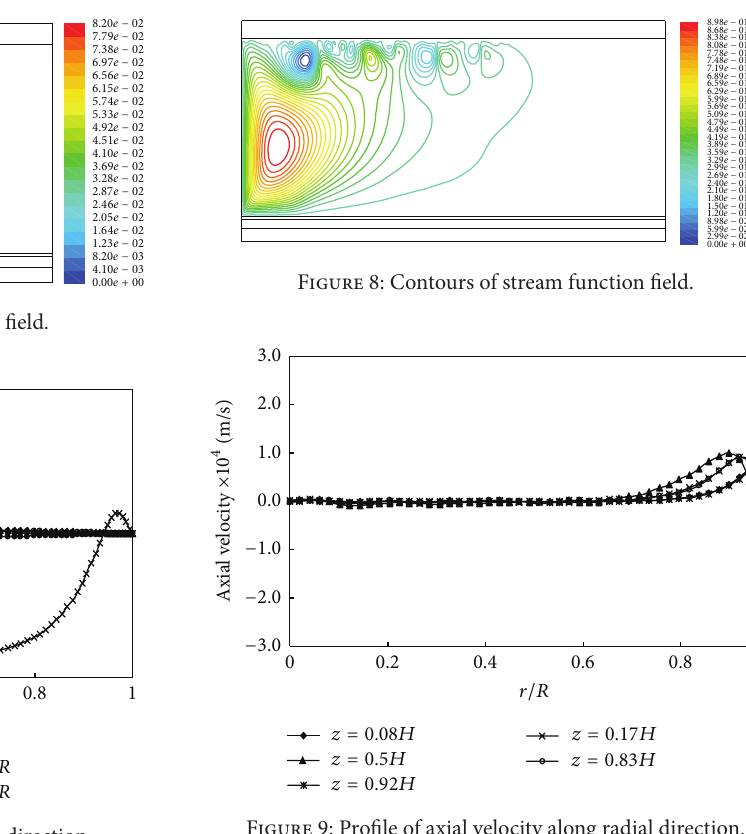
Figure 7: Profile of axial velocity along axial direction.